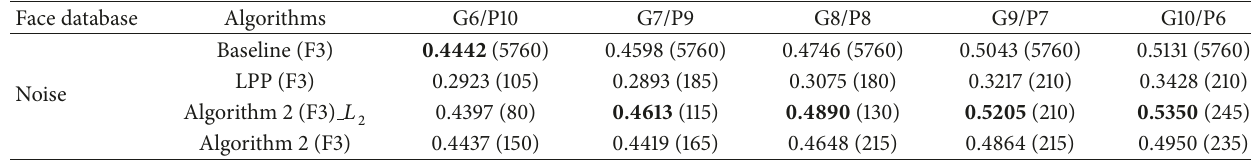
Table 23: The recognition rates on noise Extended Yale B face database over “F3” features; recognition rates